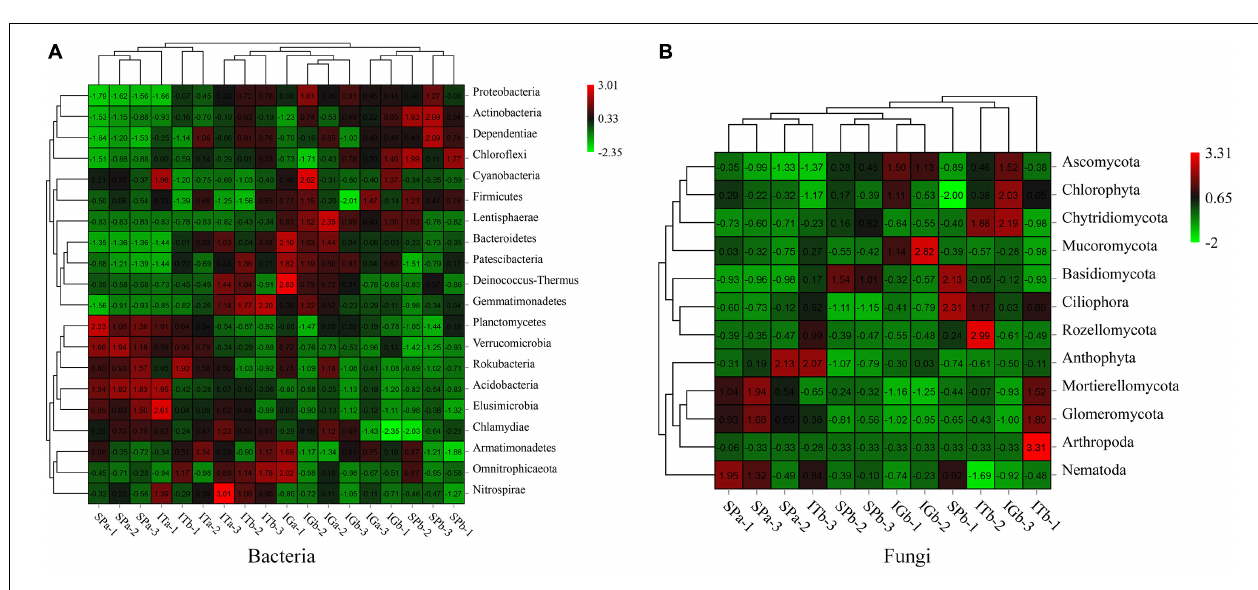
FIGURE 4 | Clustering results and the relative abundance heat maps for the bacteria (A) and fungi (B) .